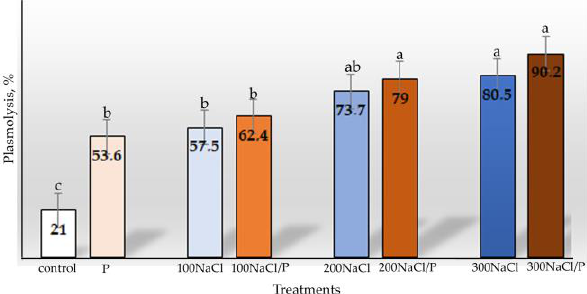
Figure 8. Dependence of plasmolysis development in stem cells of young Chenopodium quinoa on